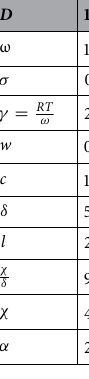
Table 1. Values of parameters employed in